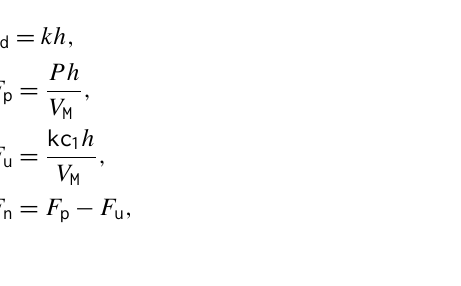
c (cid:48) − c (cid:48) e , app c − c e , app vs. ln c 1 − c e , app − c (cid:48) c (cid:48) e , app 1